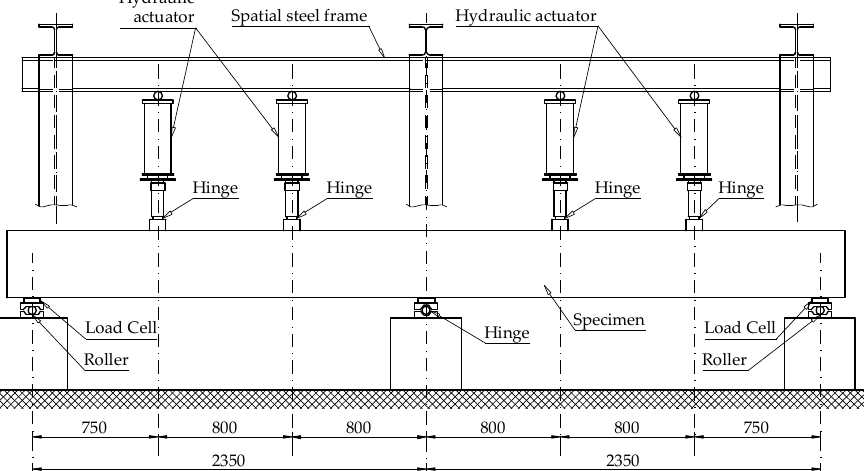
Figure 4. Test setup of the double span beams. The instrumentation for each beam consisted of a set of linear variable differential transformers to measure the strain in the top and bottom fibres of the support and span sections. The measurement base was fixed at 200 mm. In addition, the deflections of both spans were also measured using a set of LVDT mounted on a special bar. The data were collected using a special computer data acquisition system. The instrumentation scheme is shown in Figure 5. In addition, the data in the zones of expected plastic hinges were collected using an Aramis optical photogrammetry system. Figure 5. Specimen instrumentation scheme.